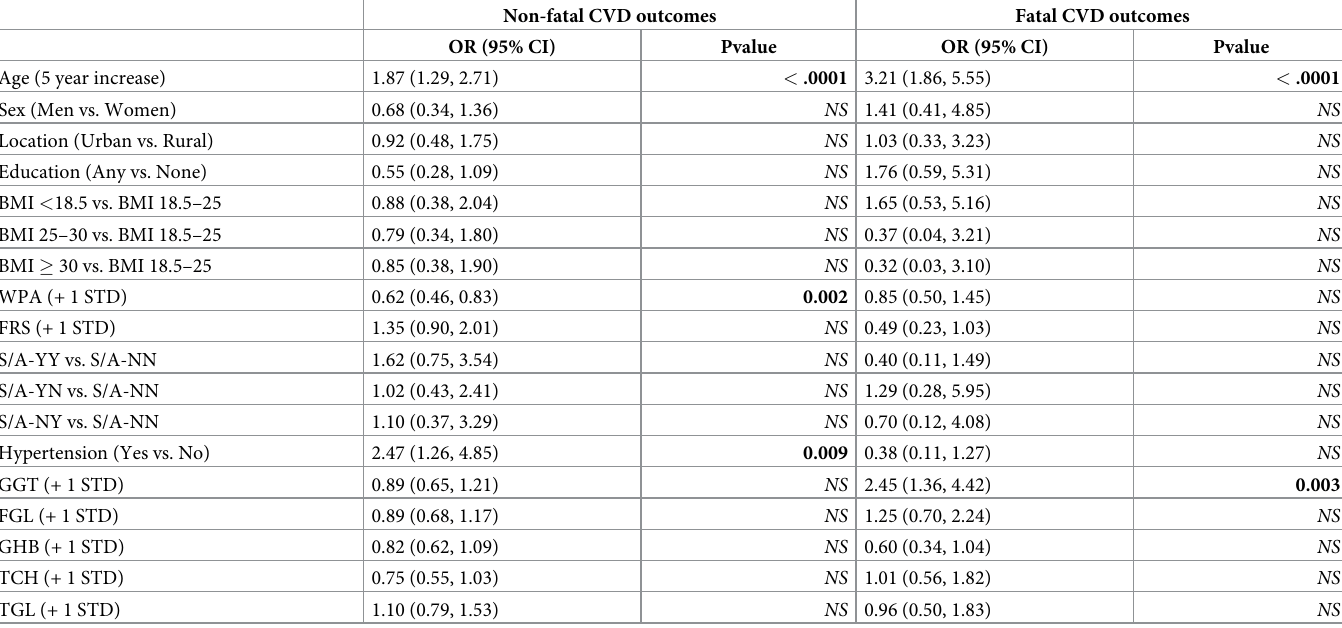
Table 3. Odds ratios (OR) and 95% confidence intervals (95% CI) of sample‘s features in relation to non-fatal and fatal cardiovascolar